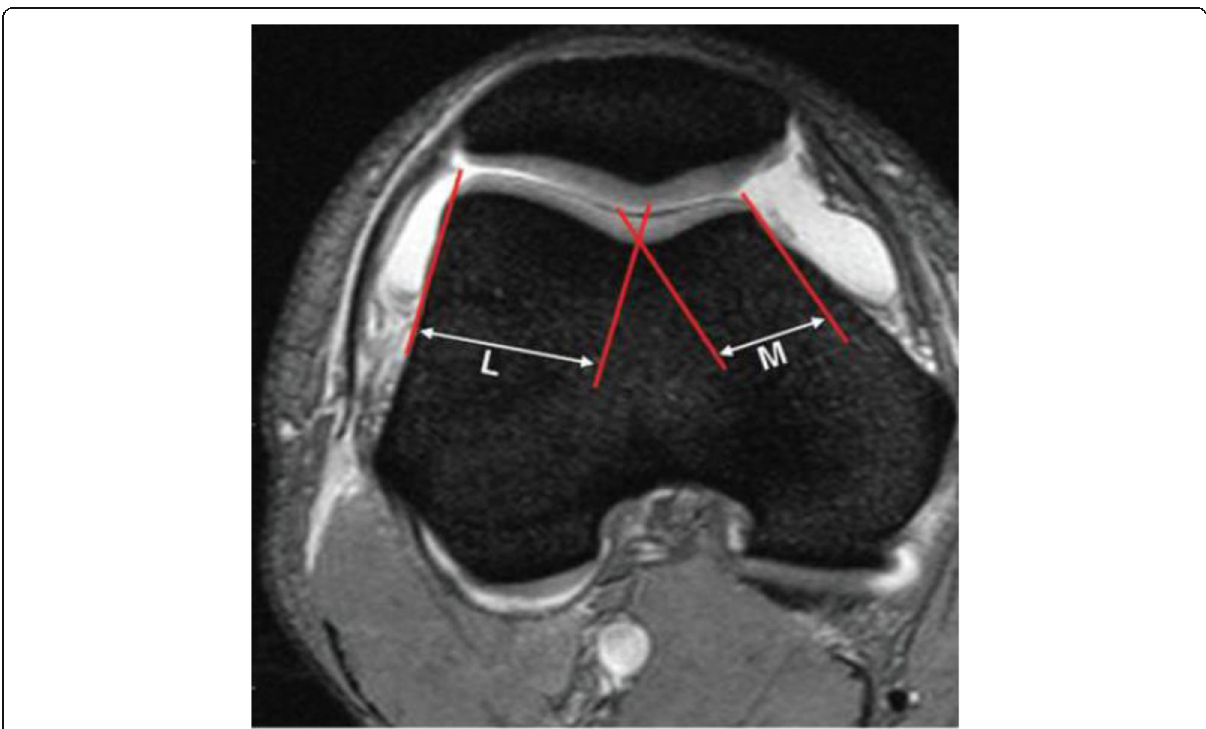
Fig. 3 Axial fat-saturated T2-weighted MR image for assesment of the asymmetry of the femoral trochlear facets. The percentage of the asymmetry of the medial facet ( M ) and the lateral facet ( L ) lengths was calculated as (M/L × 100%). A trochlear facet asymmetry ratio < 40% was considered as an indicator of trochlear dysplasia